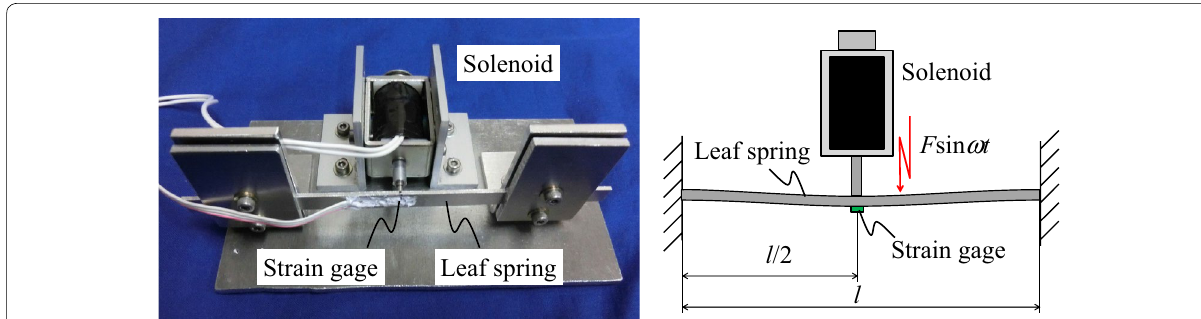
Fig. 7 Experimental setup to measure the pushing force of the solenoid at each frequency